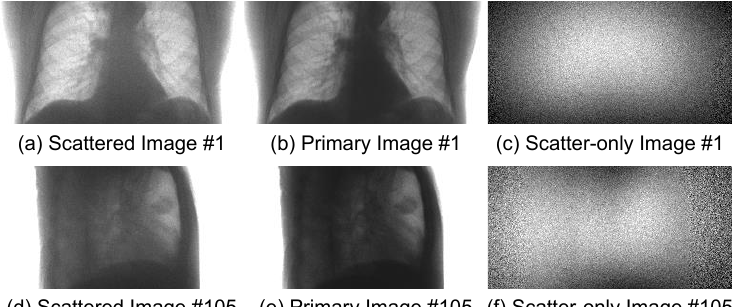
Figure 4. Examples of pairs of scattered and scatter-free primary images with their residuals.